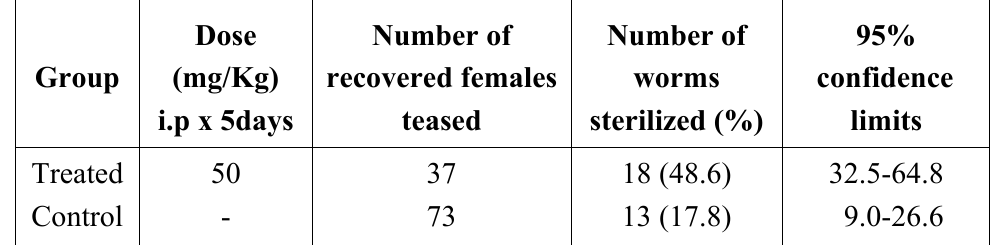
Table 2. Sterilizing effect shown by 2-isopropyl-5-methylphenol in recovered adult worms from treated